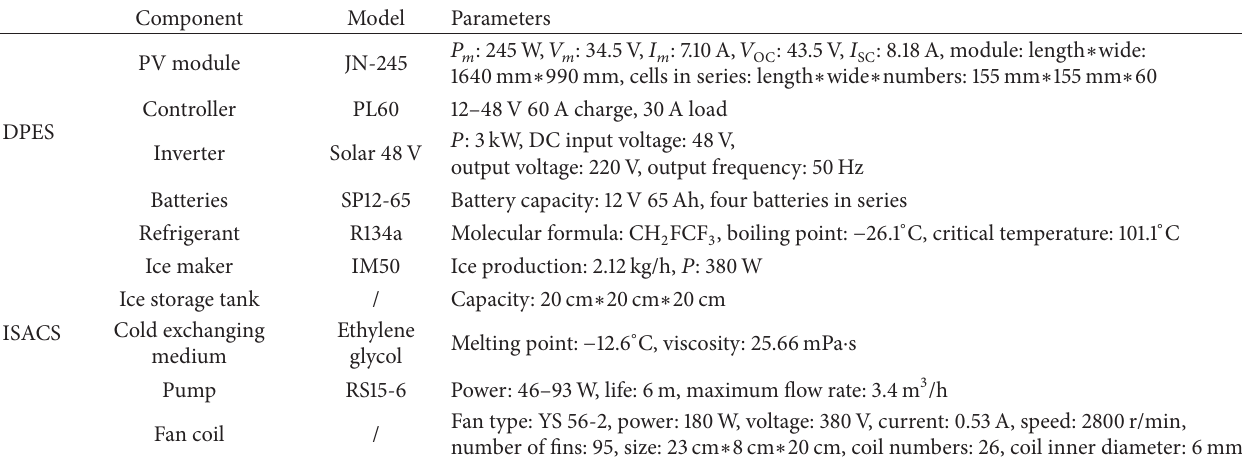
Table 1: Main component parameters of ISACS driven by DPES.